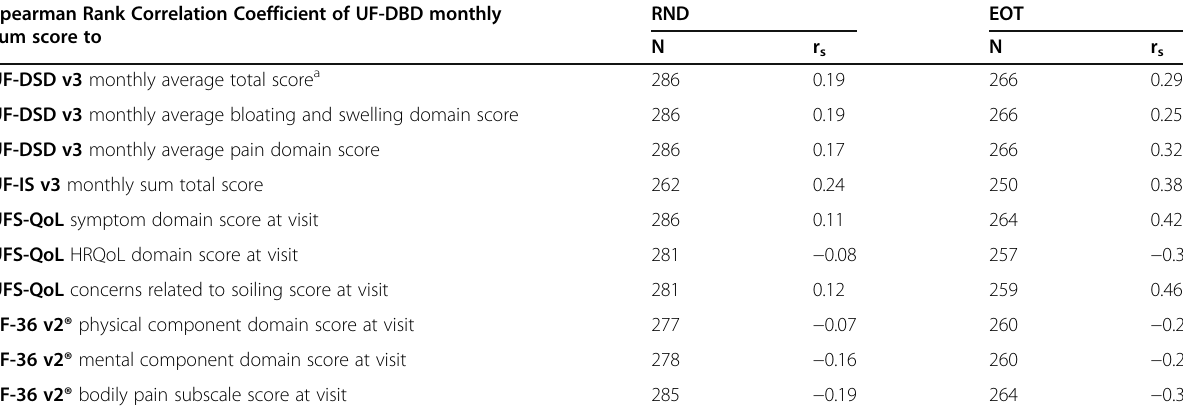
Table 3 Convergent and divergent validity analysis with UF-DBD and reference measures (monthly sum scores) Spearman Rank Correlation Coefficient of UF-DBD monthly sum score to